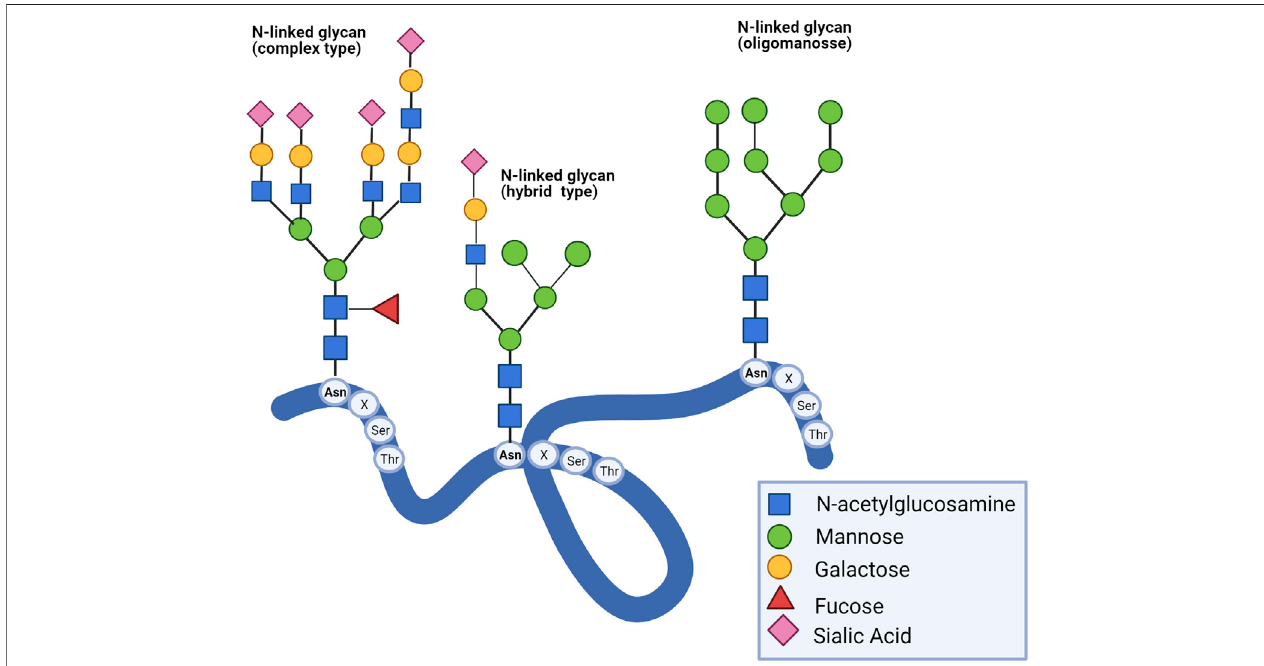
FIGURE 1 | Type of N-glycans. There are three types of N-glycans: complex, hybrid, and oligomannose. All eukaryotic N-glycans share a consensus core sequence Man α 1-6(Man α 1-3) Man β 1-4GlcNac β 1-4GlcNac β 1-Asn-X-Ser/Thr (Stanley et al.,